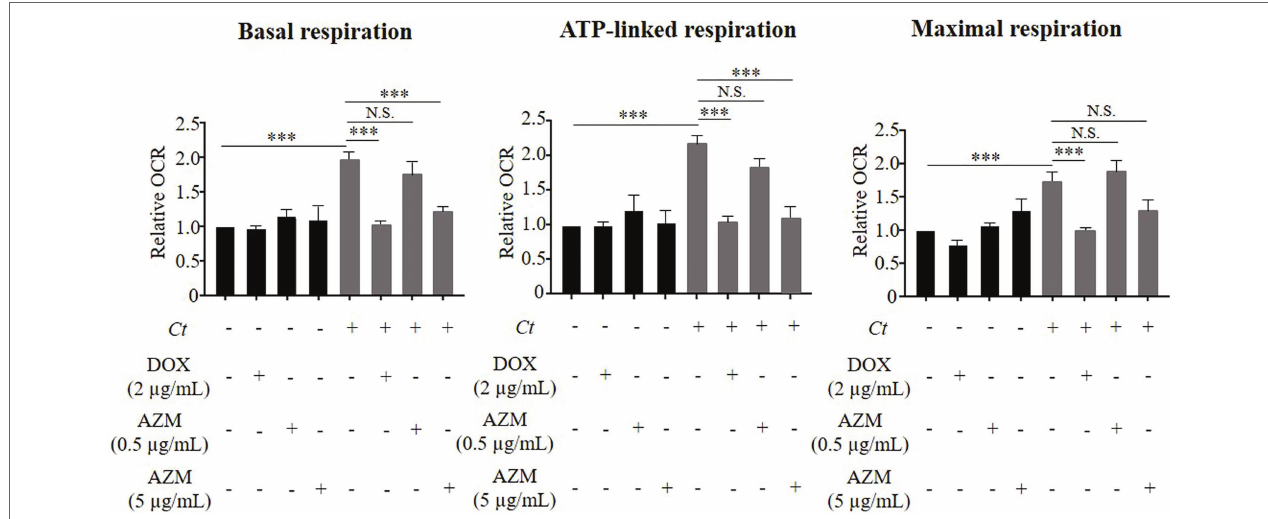
FIGURE 3 | Impact of DOX and AZM on mitochondrial activity in C. trachomatis infected HeLa cells. Cells were treated with 2 μ g/ml of DOX, 0.5 or 5 μ g/ml of AZM for 24 h. Mitochondrial activity, indicated by basal respiration, ATP-linked respiration and maximal respiration was measured by Mito Stress test kit. OCR, oxygen consumption rate; Ct , C. trachomatis ; DOX, doxycycline; AZM, azithromycin ( n = 3–12; Mean ± SEM, Sidak’s multiple comparison: *** p ≤ 0.001; N.S. not